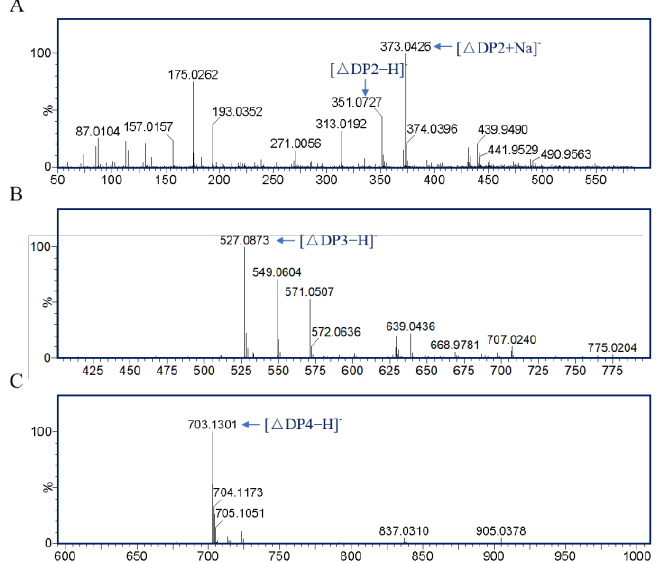
Figure 7. Mass spectrometry (MS) analysis of the peaks in Figure 6. ( A ) MS analysis of the peaks ∆DP2 at 4.6 min in Figure 6B; ( B ) MS analysis of the peaks ∆DP3 at 6.5 min in Figure 6B; ( C ) MS analysis of the peaks ∆DP4 at 7.6 min in Figure 6B.